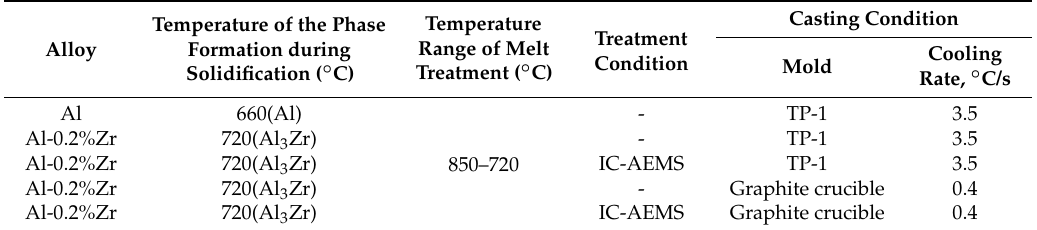
Table 2. Chemical composition, casting conditions, and characteristics of experimental alloys.